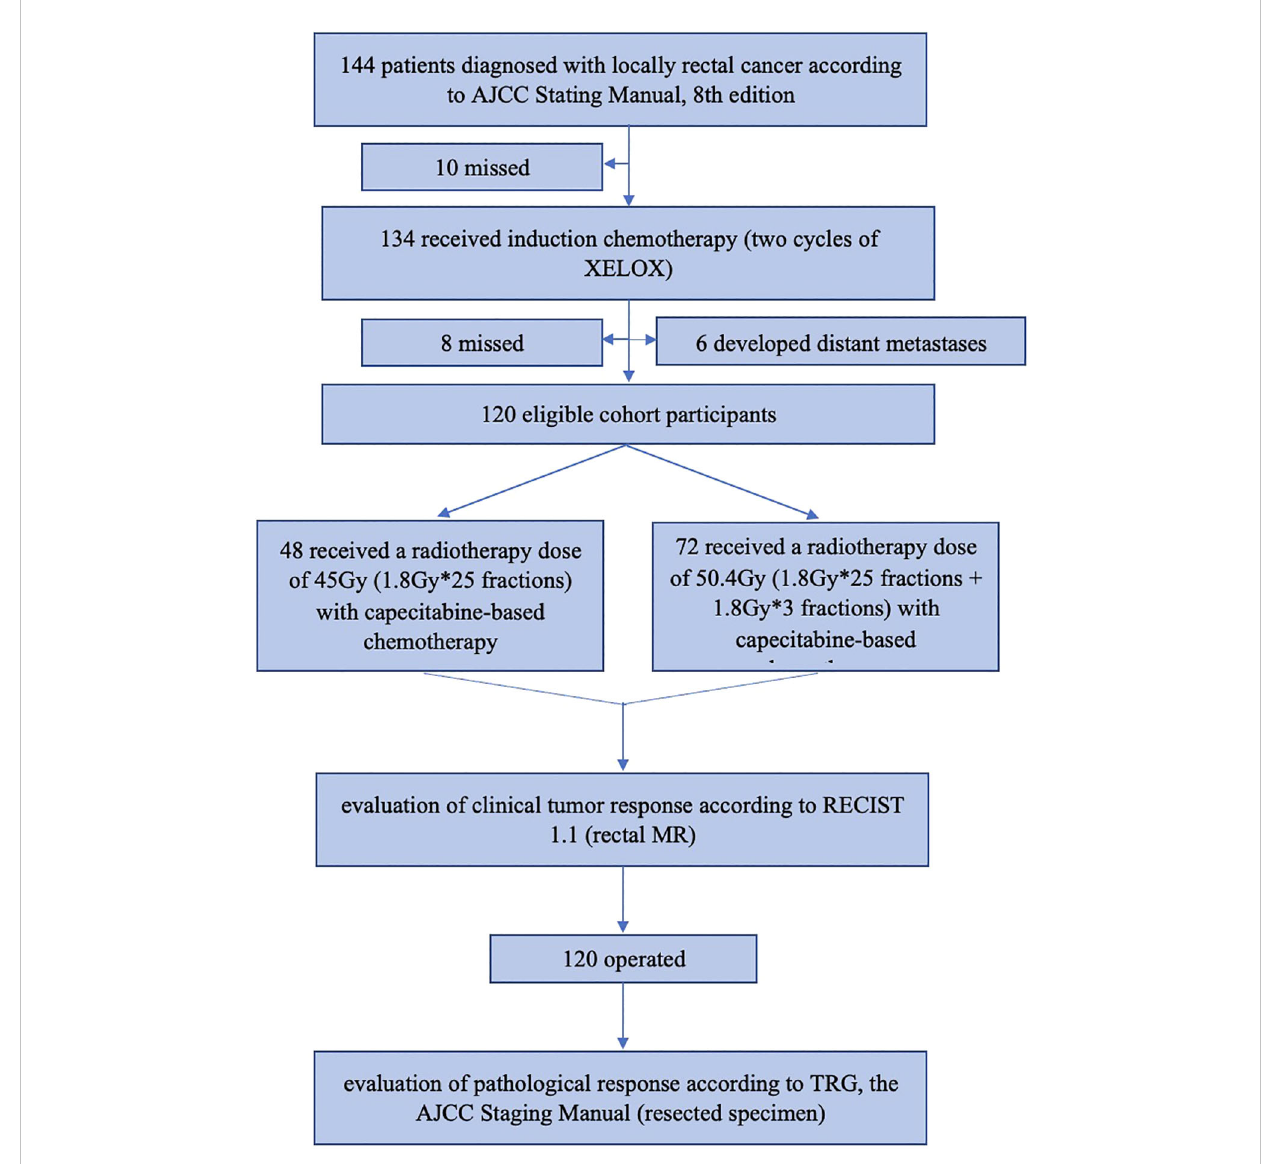
FIGURE 1 The patients fl ow diagram. AJCC, American Joint Committee on Cancer; XELOX regimen, Oxaliplatin in combination with capecitabine; MR, magnetic